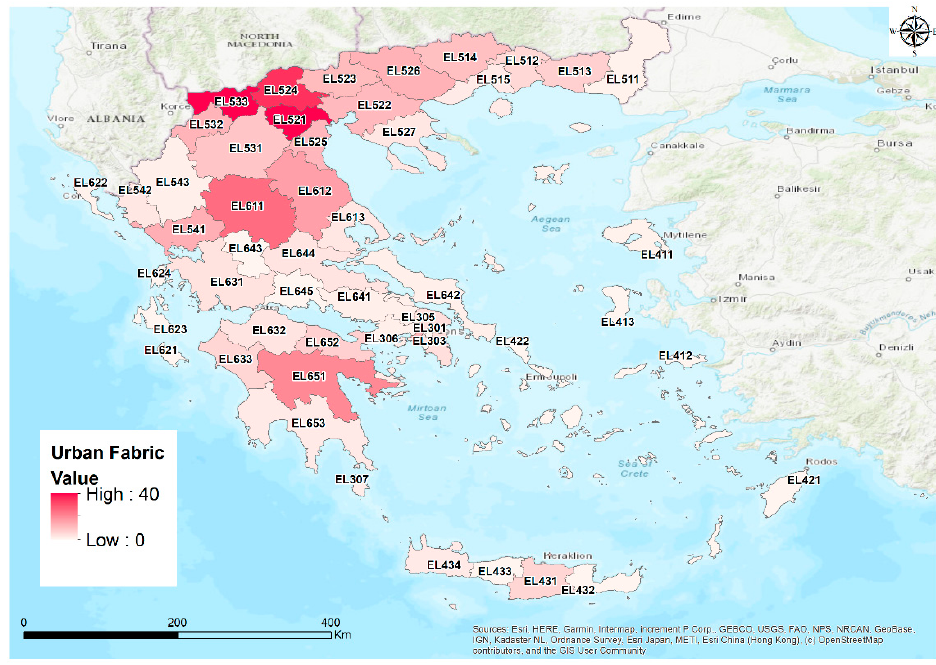
Figure 10. Spatial distribution of the ratio of the urban fabric in flood zones per NUTS 3.